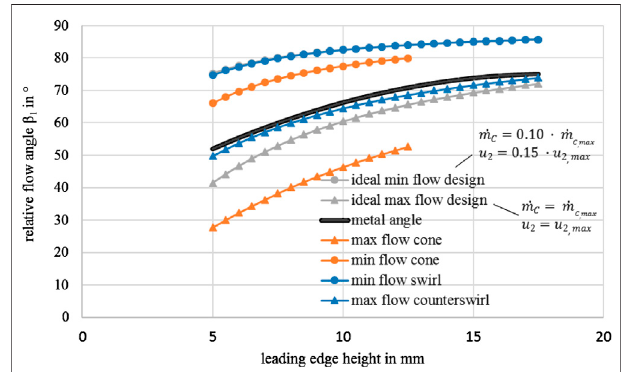
FIGURE 2 | Calculated leading edge designs for different fl ow conditions.